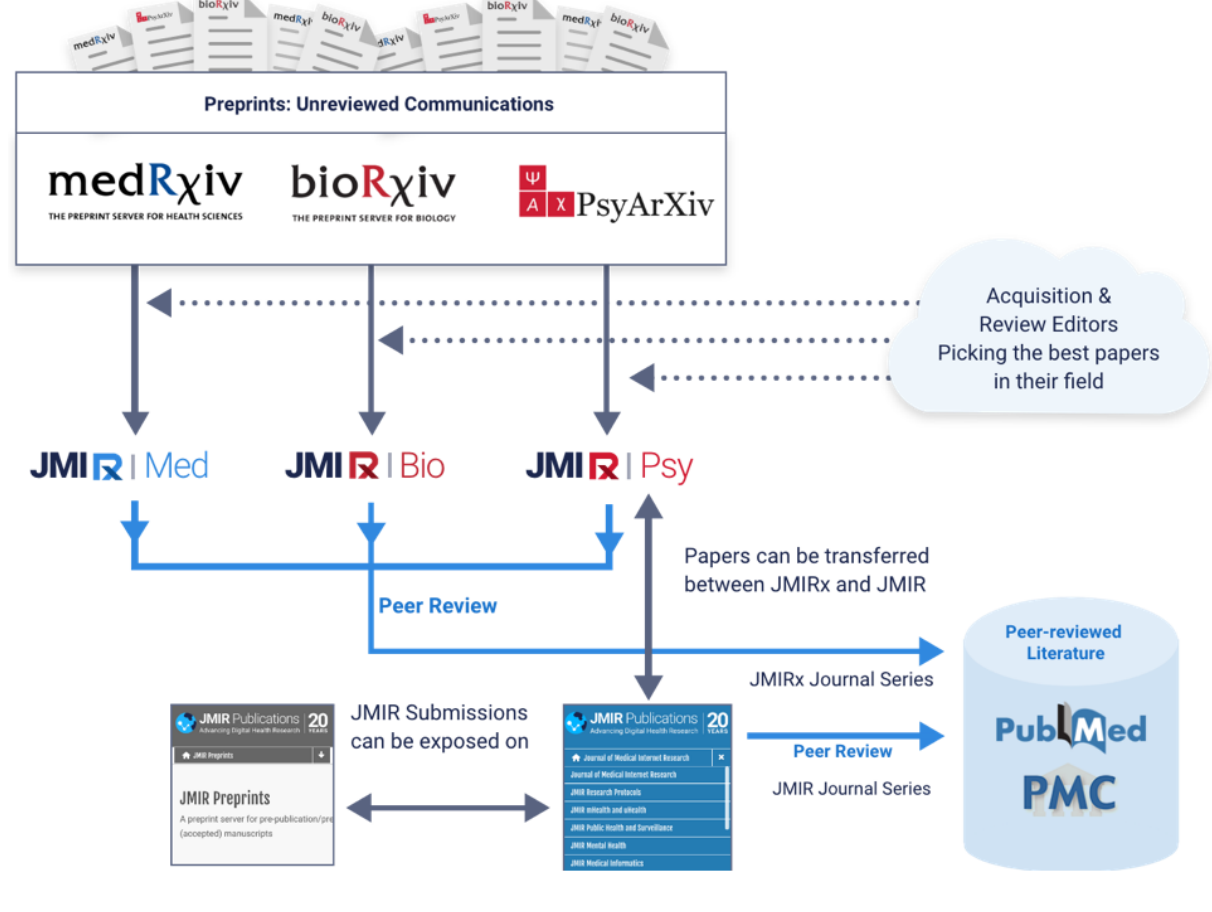
Figure 2. JMIRx, a new series of superjournals (overlay journals) offering peer review and publication services for